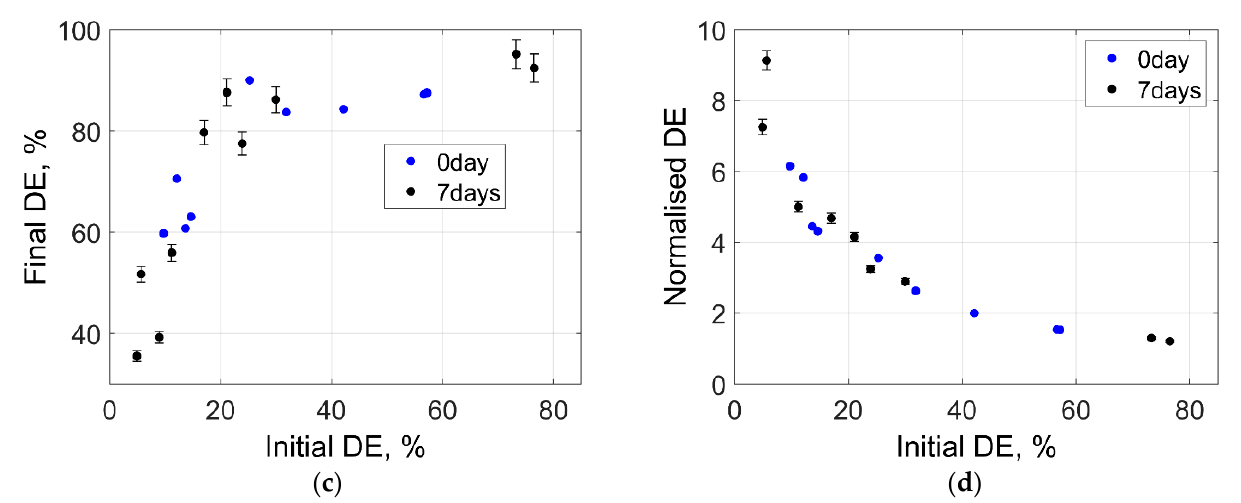
Figure 3. ( a ) Real-time diffraction efficiency growth during holographic recording on PHSG layers with thickness of 118 μ m prepared using the sol with ages of 0 and 7 days; ( b ) Bragg selectivity curves of gratings recorded as shown on Figure 3a and measured in 24 h after recording; ( c ) final diffraction efficiency (DE) measured 24 h after exposure versus the initial diffraction efficiency obtained during exposure; ( d ) normalised DE versus initial DE shows the level of the enhancement during dark process.